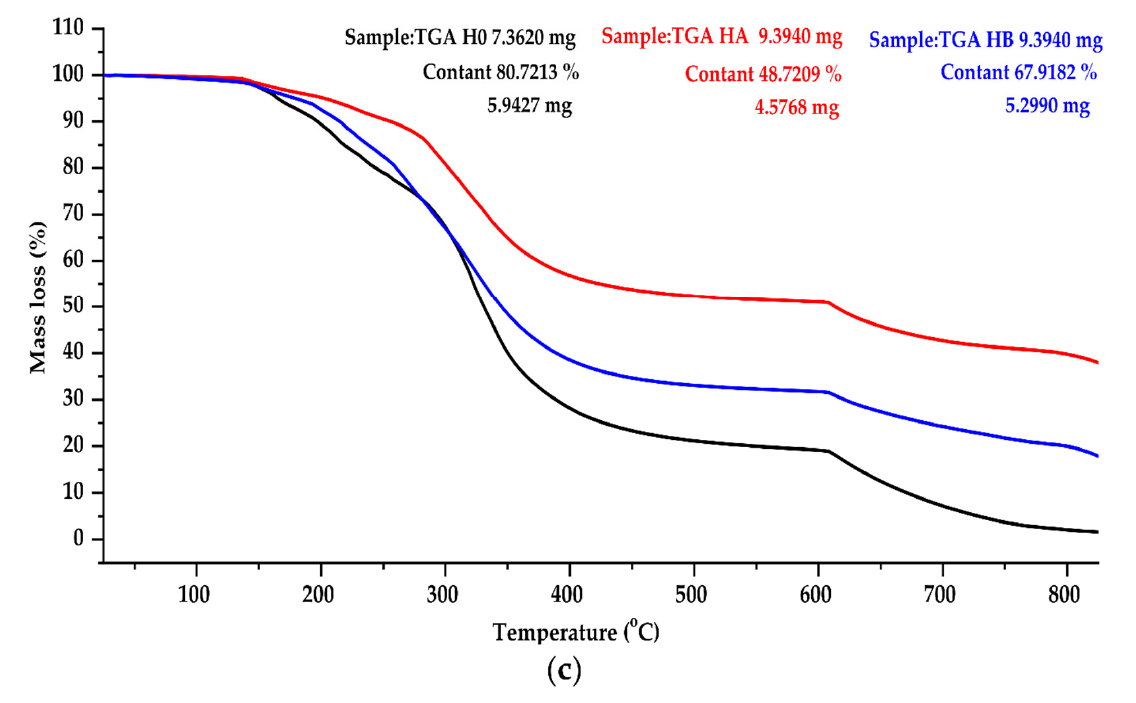
2 Figure 6. Results of DSC ( a ) and ( b ) and TGA ( c ) for the composites: H0 (black line), HA (red line), HB (blue line). Table 3. Influence of collagen–gelatin composites on the thermal properties of HO, HA, and HB. Composites